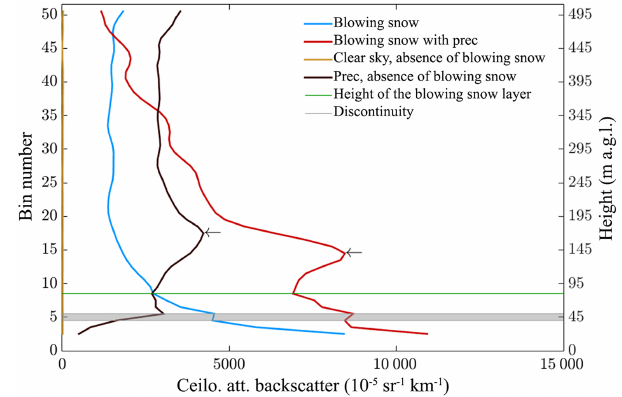
Figure 6. Different types of hourly-averaged one-event profiles rel- evant for blowing snow measured by the ceilometer at PE station: the blue line shows typical blowing snow signal with no precipita- tion nor clouds (24 April 2016); the red line shows blowing snow overlaid by precipitation (10 February 2016); the black line shows precipitation in the absence of blowing snow (10 February 2014); the yellow line shows the near-zero signal for clear-sky conditions (24 April 2016). The height above ground is indicated on the right axis and the corresponding bin number on the left axis. All profiles exclude the lowermost bin, and start at the second bin (15ma . g . l . .). The grey lines represent the discontinuity between bins 4 and 5 (35– 45m). The arrows indicate the presence of precipitation. The rein- crease in ceilometer profile indicator of the presence of clouds and precipitation is indicated in